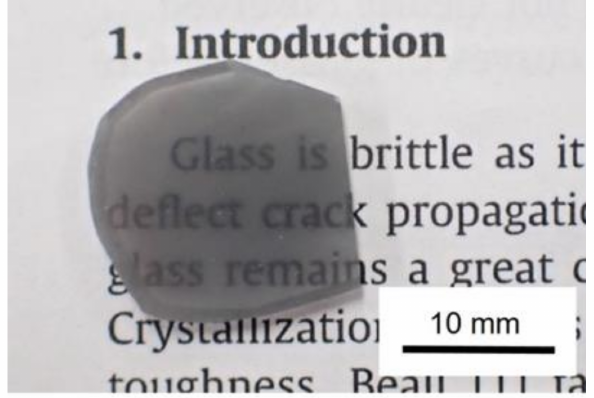
Figure 4. Appearance of a 1.5 mm-thick CAS glass-ceramic doped with 0.05 wt% MoO 3 [24].